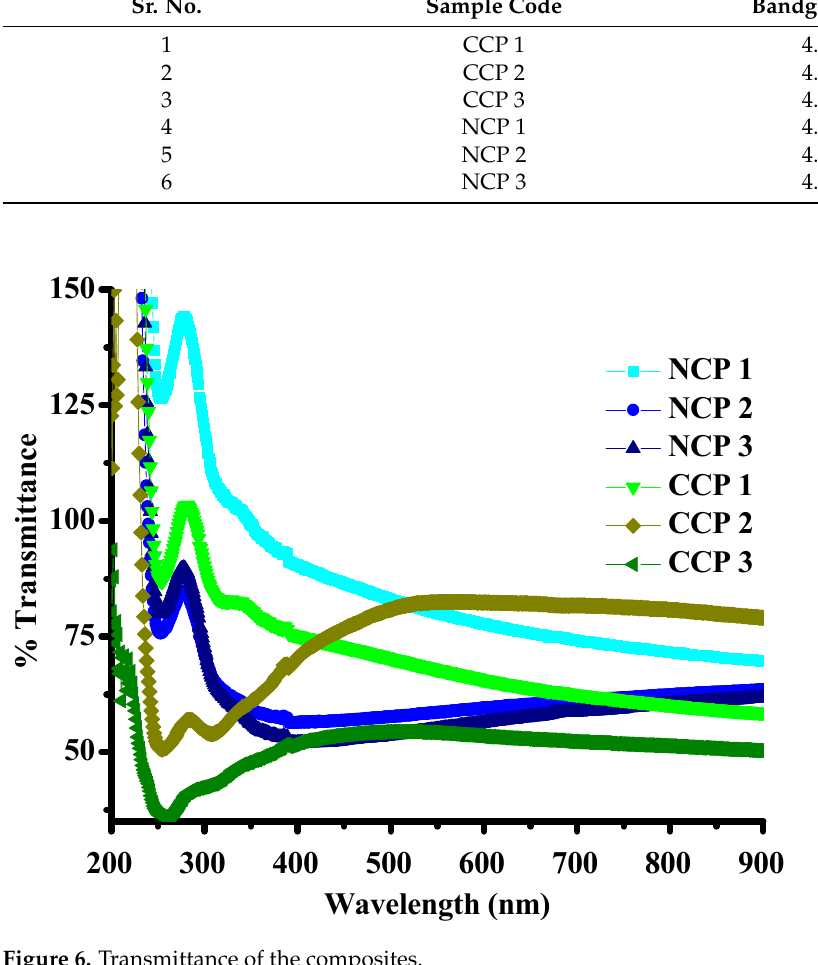
Table 2. The bandgap energies for the composites. Sr. No.